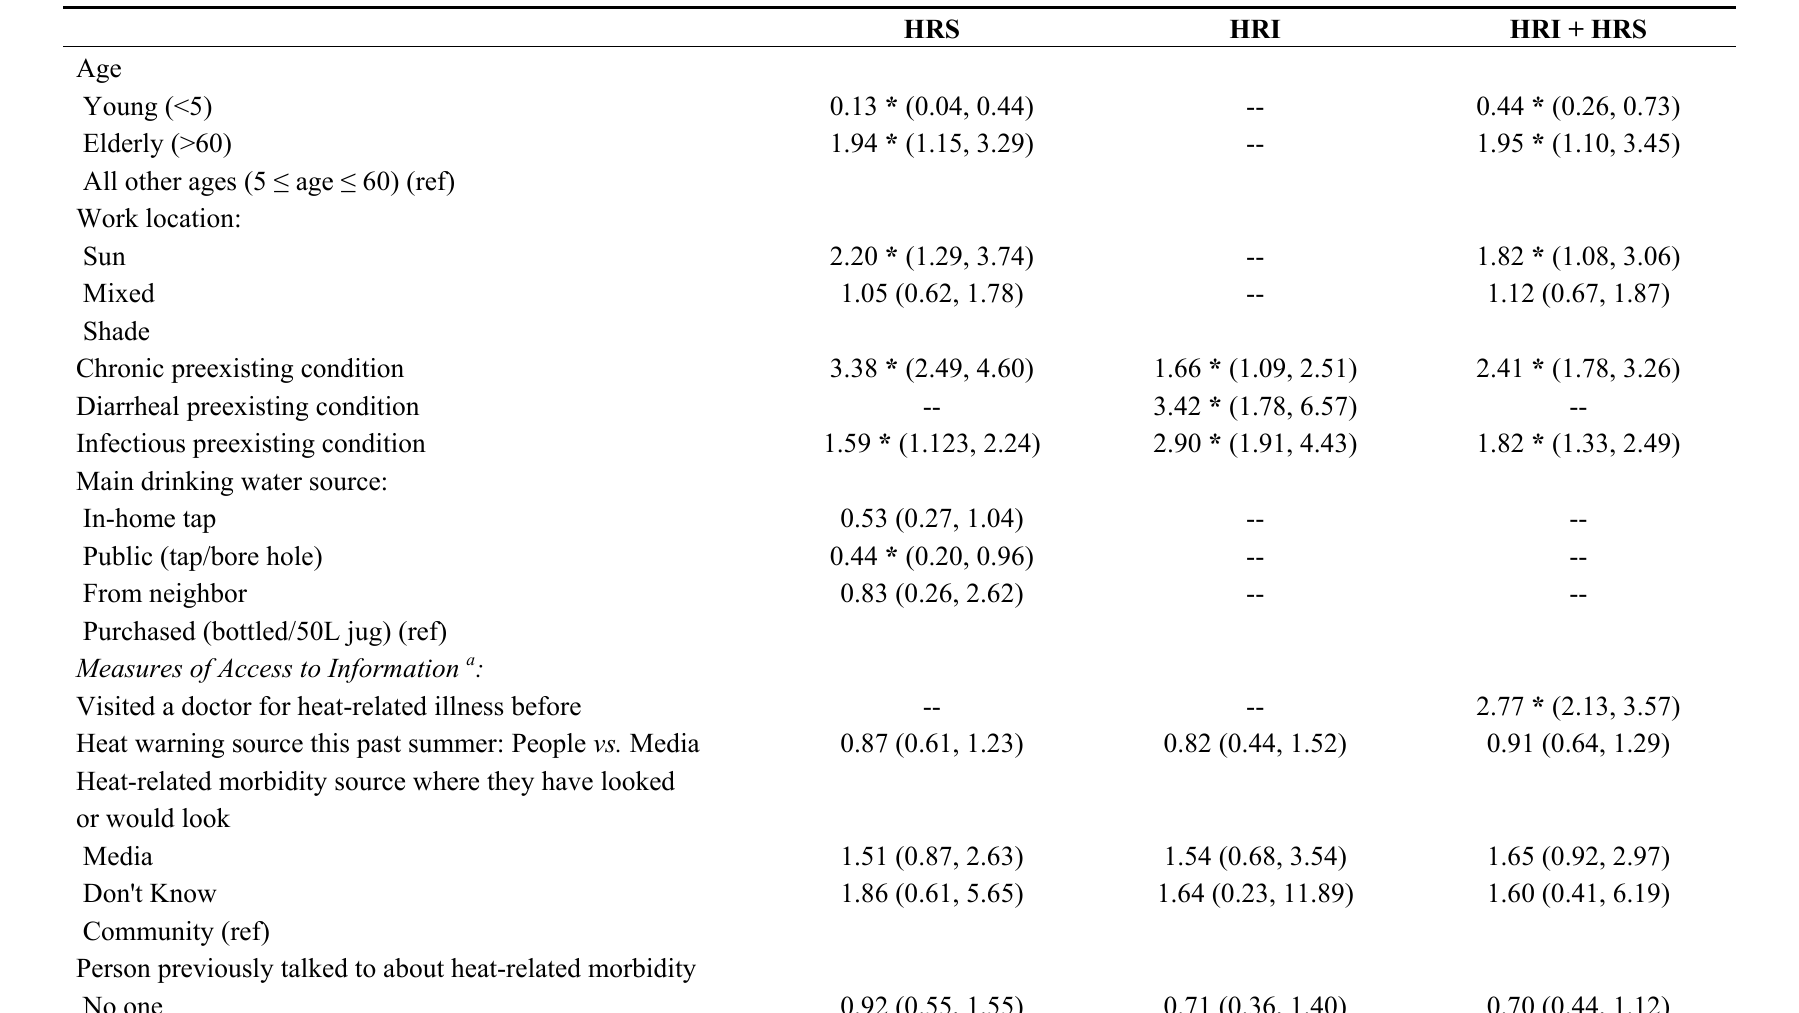
Table S5. Association between the heat-related outcomes and measures of access to information (adjusted odds ratios and 95% confidence